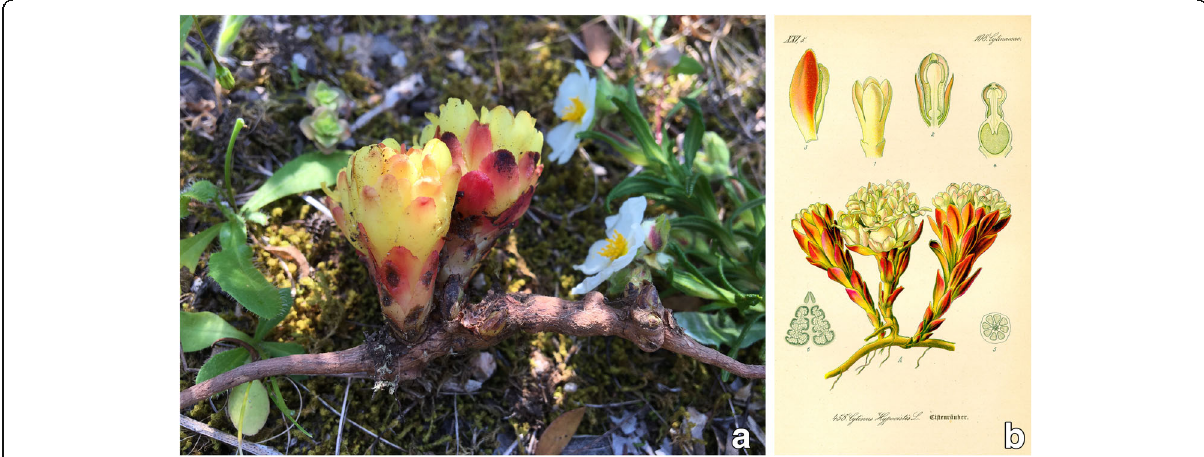
Fig. 1 a Cytinus hypocistis inflorescences, emerging directly from a Cistus monspeliensis ’ root, Sardinia; ( b ) A classic portrait of C. hypocistis (from Reference [52]; in the public domain: